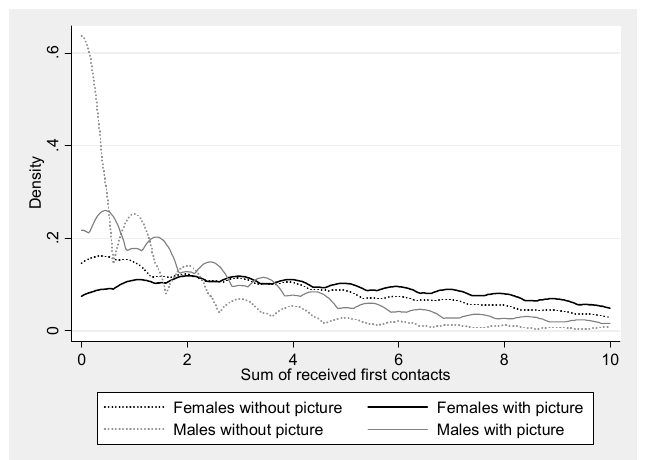
Figure 5 : Density plot of ingoing first contacts by sex and presence of profile